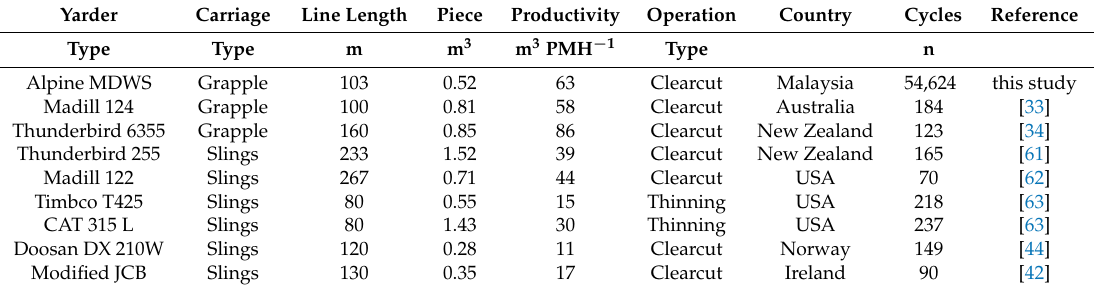
Table 6. Comparison of results between this study and previous grapple and swing yarder